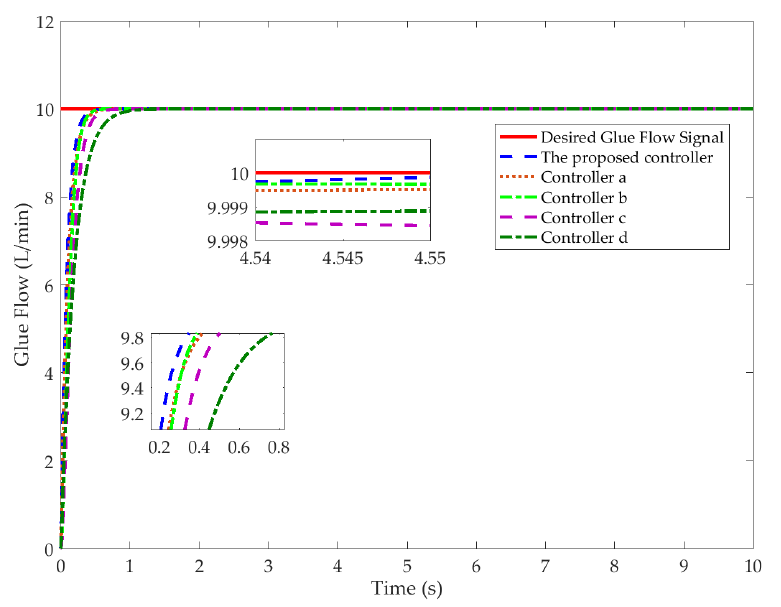
Figure 13. Time response of glue flow